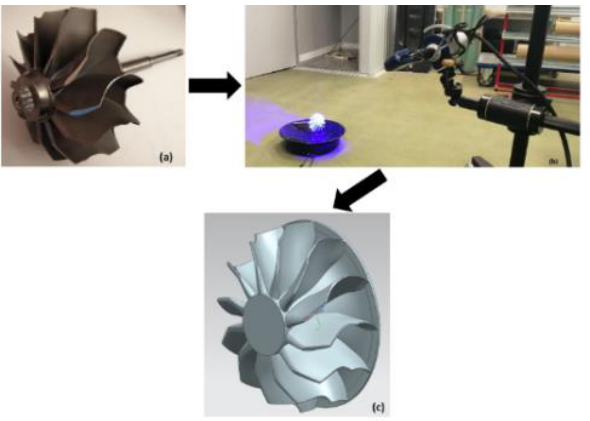
Figure 17. ( a ) Geometry of the K44 turbine, ( b ) turbine wheel scanned with the 3D scanner, and ( c ) the turbine wheel model.